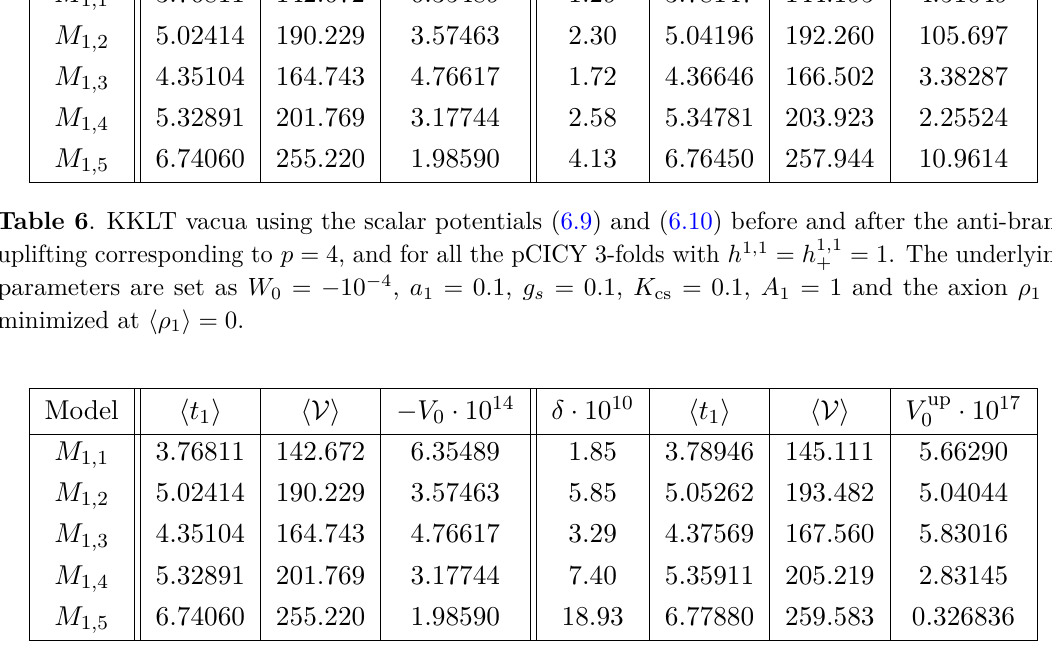
= 1 . The underlying + = − 10 − 4 , a = 0 . 1 , g = 0 . 1 , K = 0 . 1 , A = 1 and the axion ρ 0 1 s cs 1 = 0 1 i